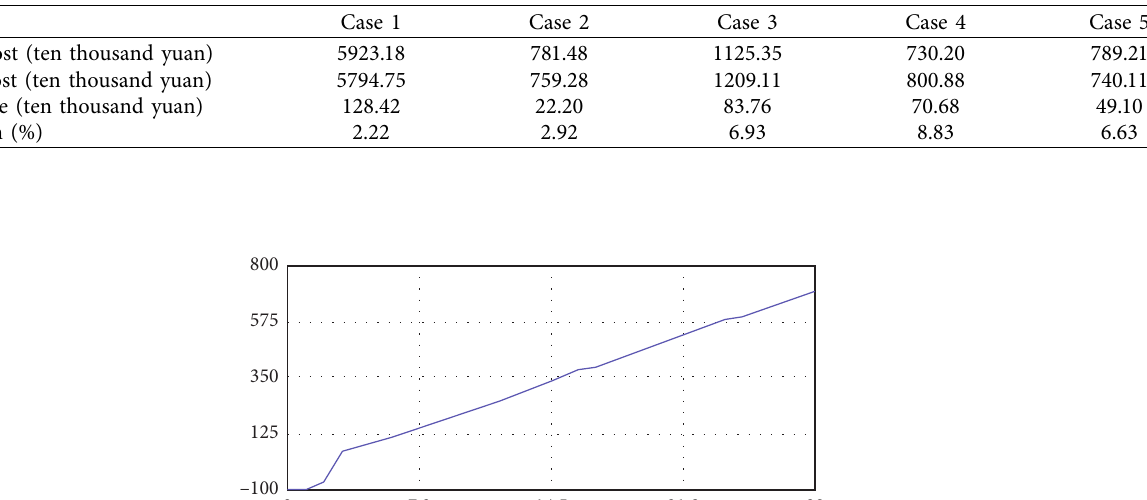
Table 4: Construction cost fitting results.